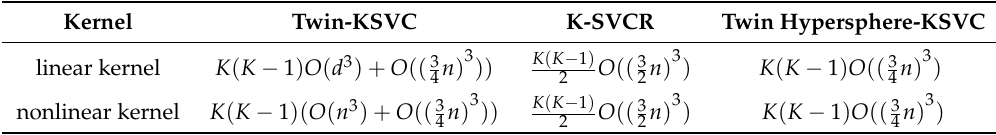
Table 1. The learning complexities of Twin-KSVC, K-SVCR and Twin Hypersphere-KSVC.